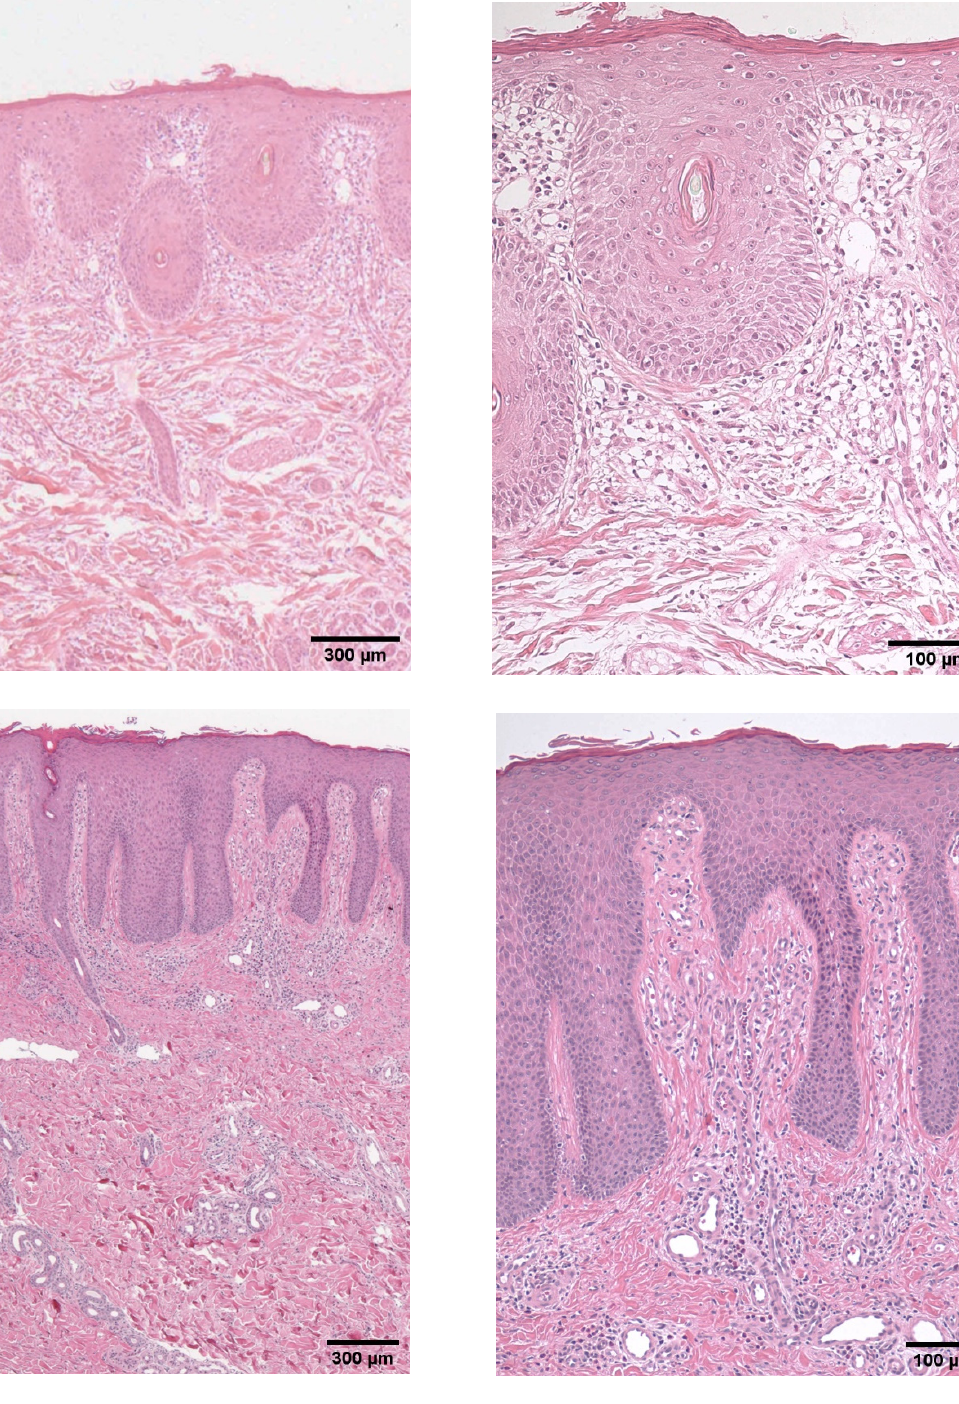
Figure 2. ( a ) Image of histopathology from trunk when he was six months old. Infiltrated lympho- cytes, edema in the upper dermis, parakeratosis, and psoriasiform hyperplasia were detected. ( b ) Image of histopathology from trunk when he was 24 years old. Infiltrated lymphocytes in the upper dermis, parakeratosis, and psoriasiform hyperplasia were detected.